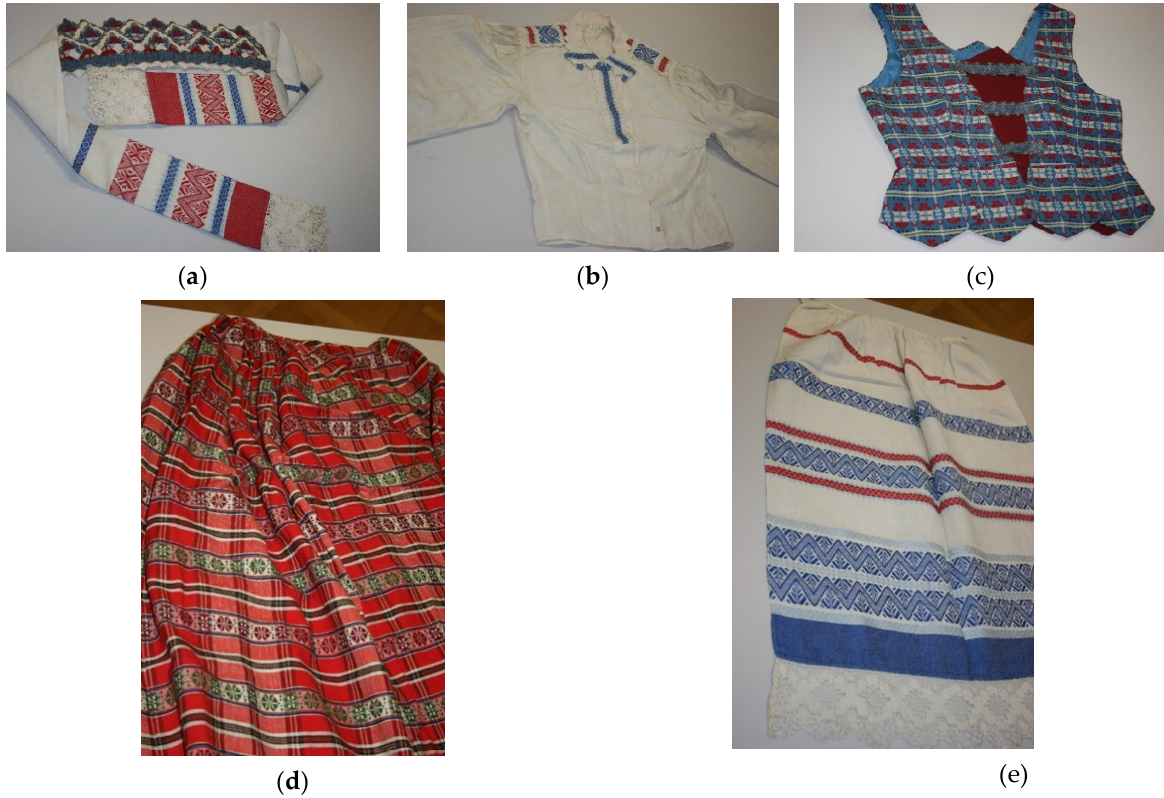
Figure 16. National costume from Samogitia woven by the company “Marginiai” according to A. Tamošaitis project in 1939: ( a ) Headdress—wide plain sash with collar ČDM E3711e; ( b ) shirt ČDM E3711a; ( c ) vest ČDM E3711d; ( d ) skirt ČDM E3711b; ( e ) apron ČDM E3711c.